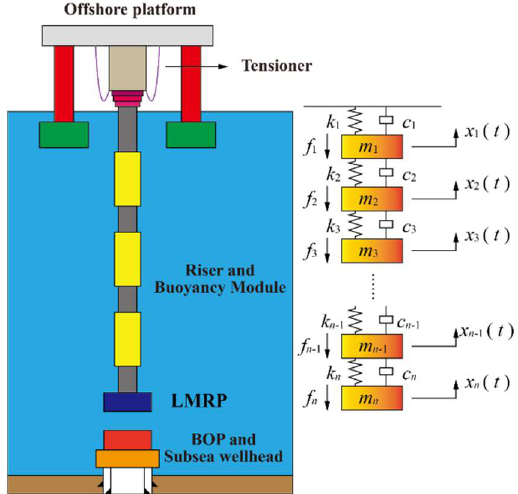
Figure 2. Mechanical analysis model of the recoil response of a deepwater drilling riser after emer- gency disconnection [38].